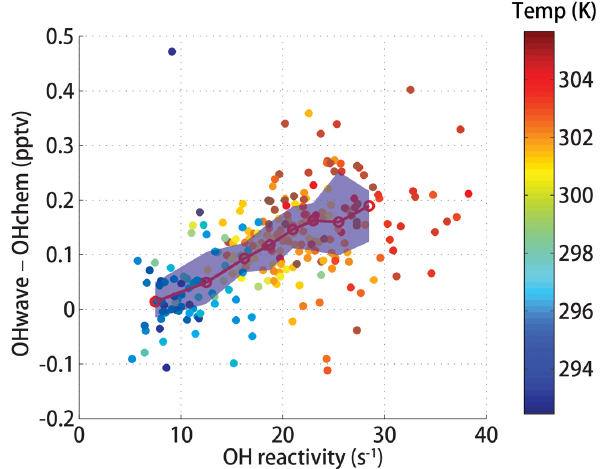
Fig. 6. Scatter plot between the measured OH reactivity and the difference between OHchem and OHwave between 09:00 and 15:00PST. The 10-min averaged points are colored by the ambi- ent temperature. The shaded blue area is the interquartile range of the data and the open circles are the median values in temperature